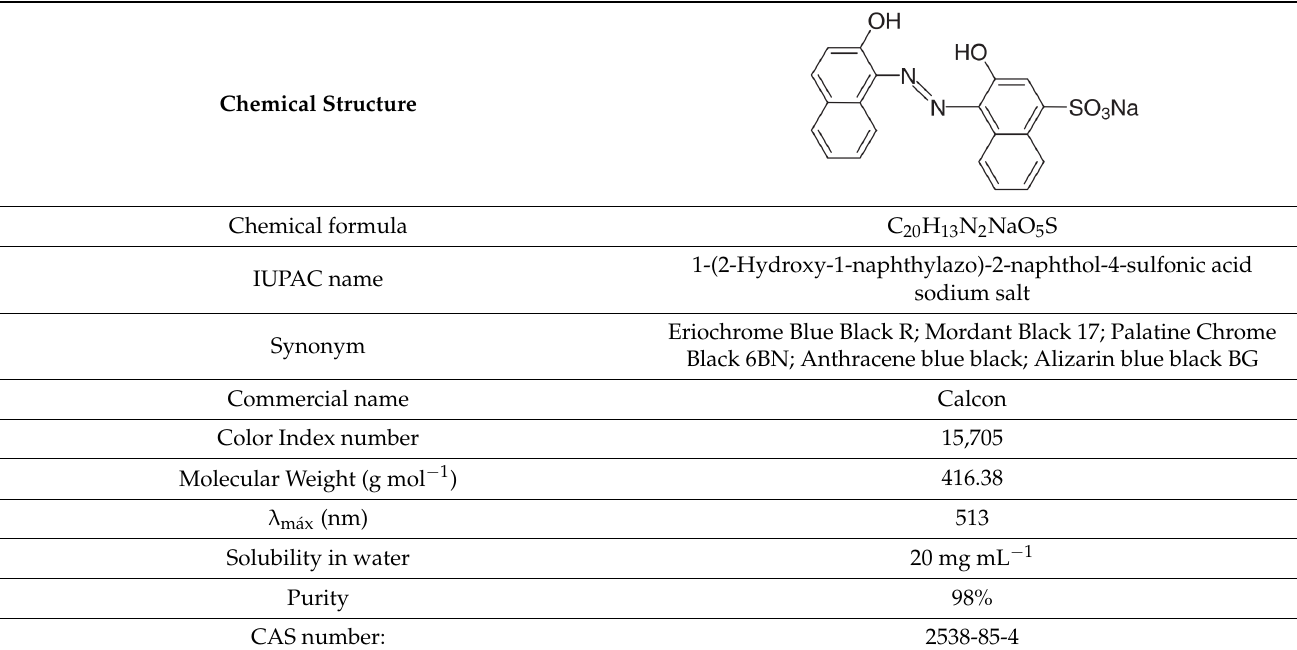
Table 1. Chemical structure and characteristics of the azo dye used in this work (Eriochrome Blue Black R).